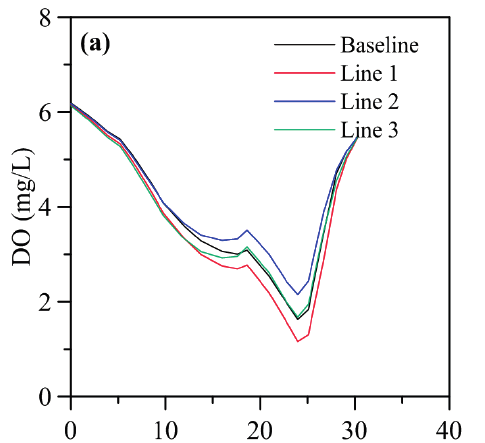
Figure 8. Predicting dissolved oxygen distribution for baseline and different cases along the ( a ) Danshuei River to Tahan Stream, ( b ) Hsintien Stream and ( c ) Keelung River. (Note that Line 1 represents a 50% increasing ratio for the nonpoint source, Line 2 represents a 50% increasing ratio for the nonpoint source and a 50% increasing ratio for the Q and Line 3 represents a 100% increasing ratio for the nonpoint source and a 50% increasing ratio for the Q 75